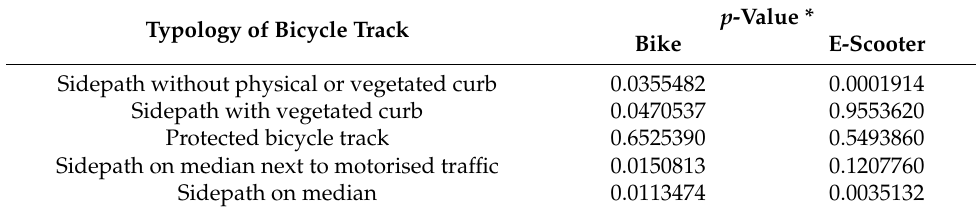
Table 4. Results of Kolmogorov–Smirnov test. Typology of Bicycle Track